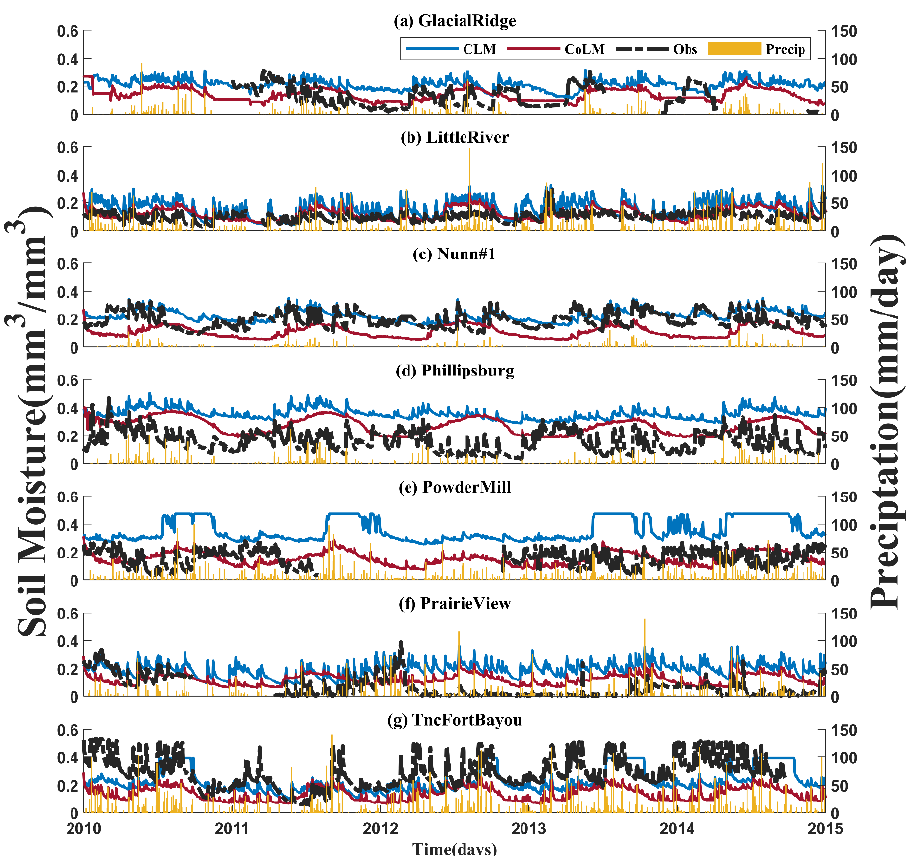
Figure 2. Simulation and observation temporal soil moisture variations at the SCAN sites for 2010 – 2014 at a soil depth of 0.0508 m. The blue line is the CLM5 simulation, the red line is the CoLM2014 simulation, the dashed line is the observations, and the yellow bars are the daily cumulative precipitation. ( a – g ) are Glacial Ridge, Little River, Nunn#1, Phillipsburg, Powder Mill, Prairie View, and Tnc Fort Bayou, respectively.